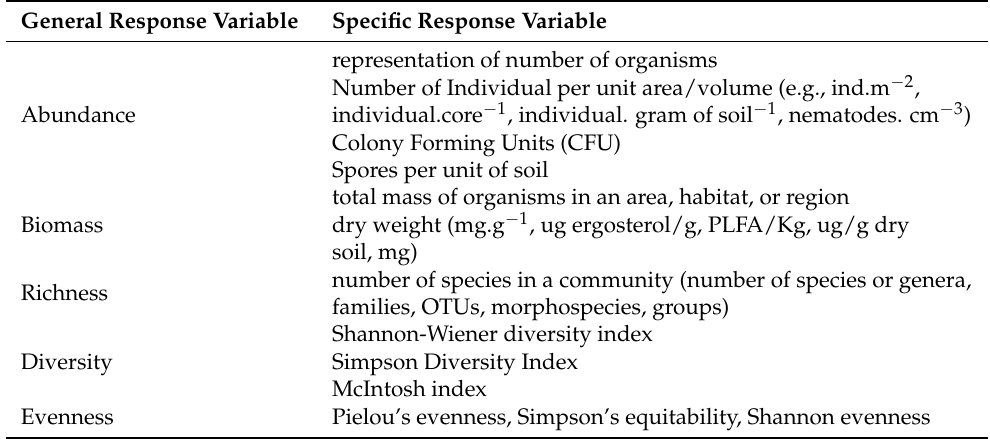
Table 2. Summary of the broad categories of response variables of studies in the meta-analysis, and the specific description of response variables that comprise